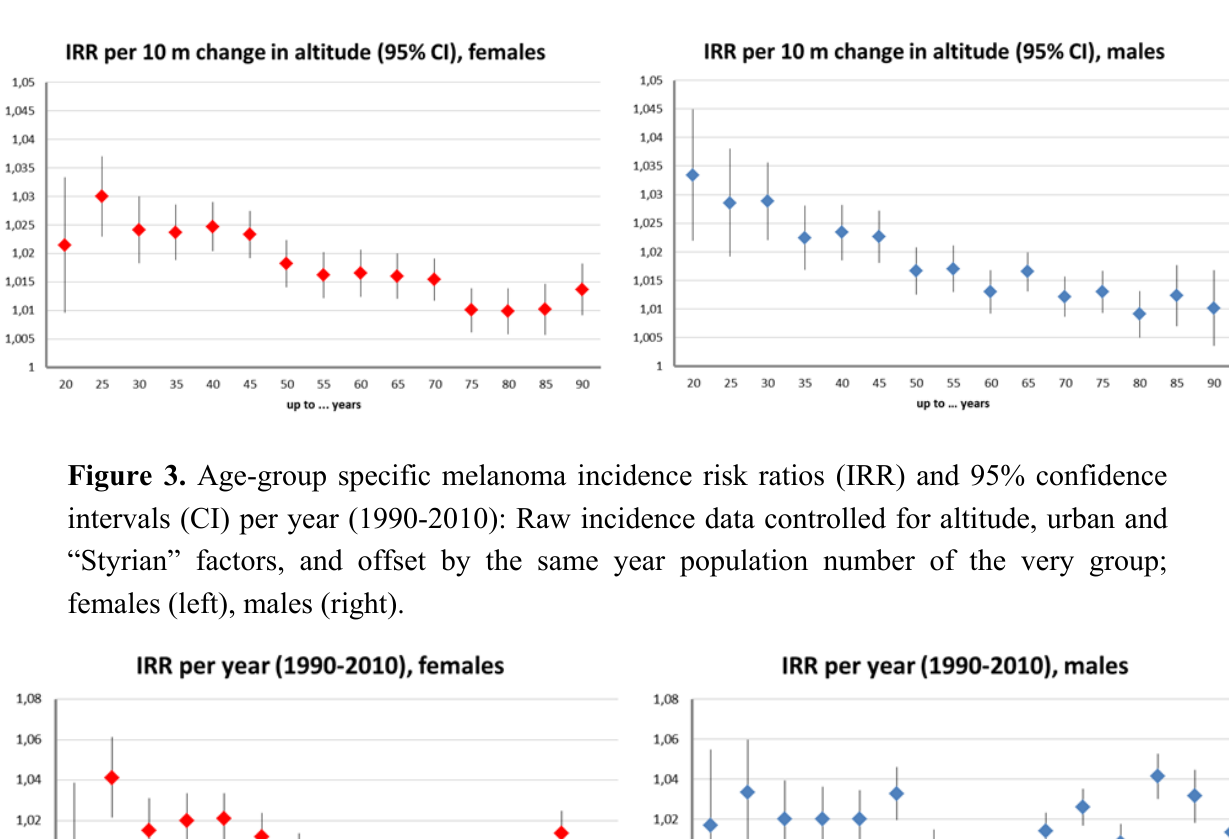
Figure 2. Age-group specific melanoma incidence risk ratios (IRR) and 95% confidence intervals (CI) per 10 m increase in altitude: Raw incidence data controlled for year, urban and “Styrian” factors, and offset by the same year population number of the very group; females (left), males (right).